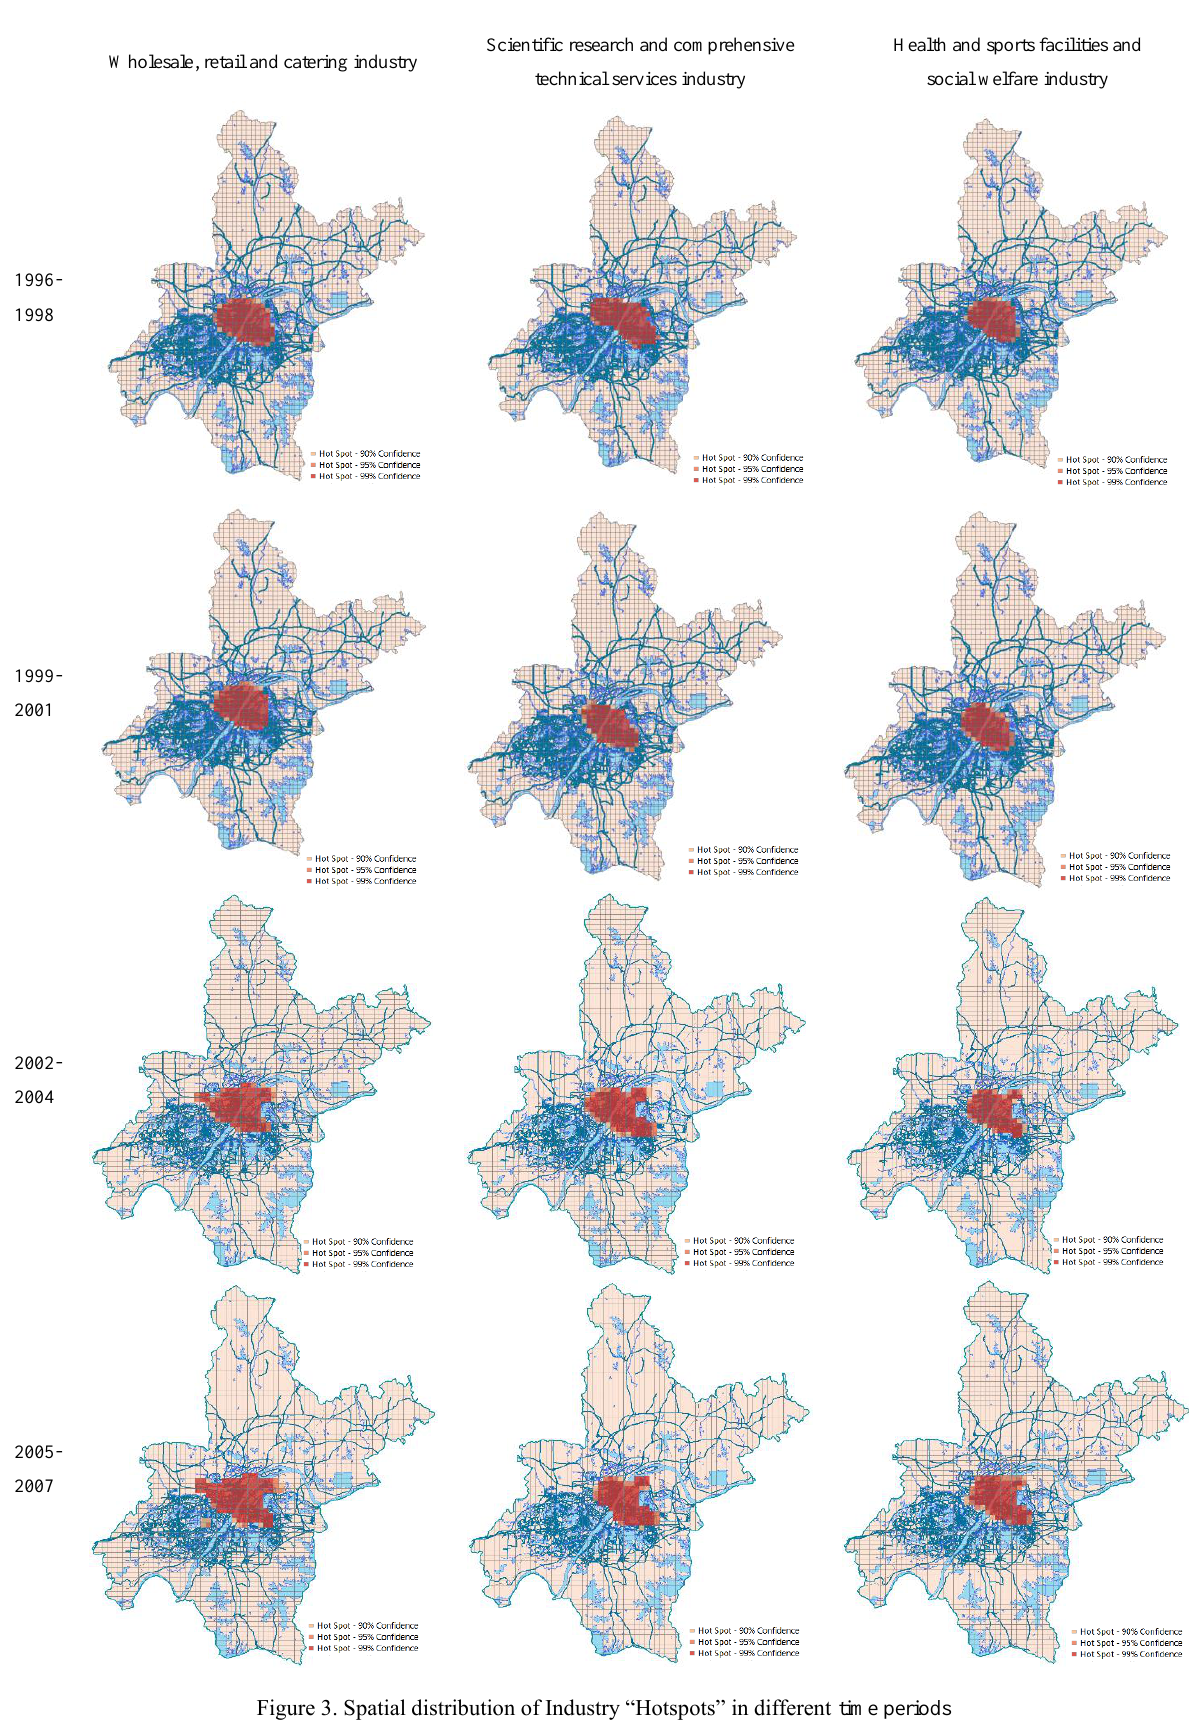
Figure 3. Spatial distribution of Industry “Hotspots” in different time